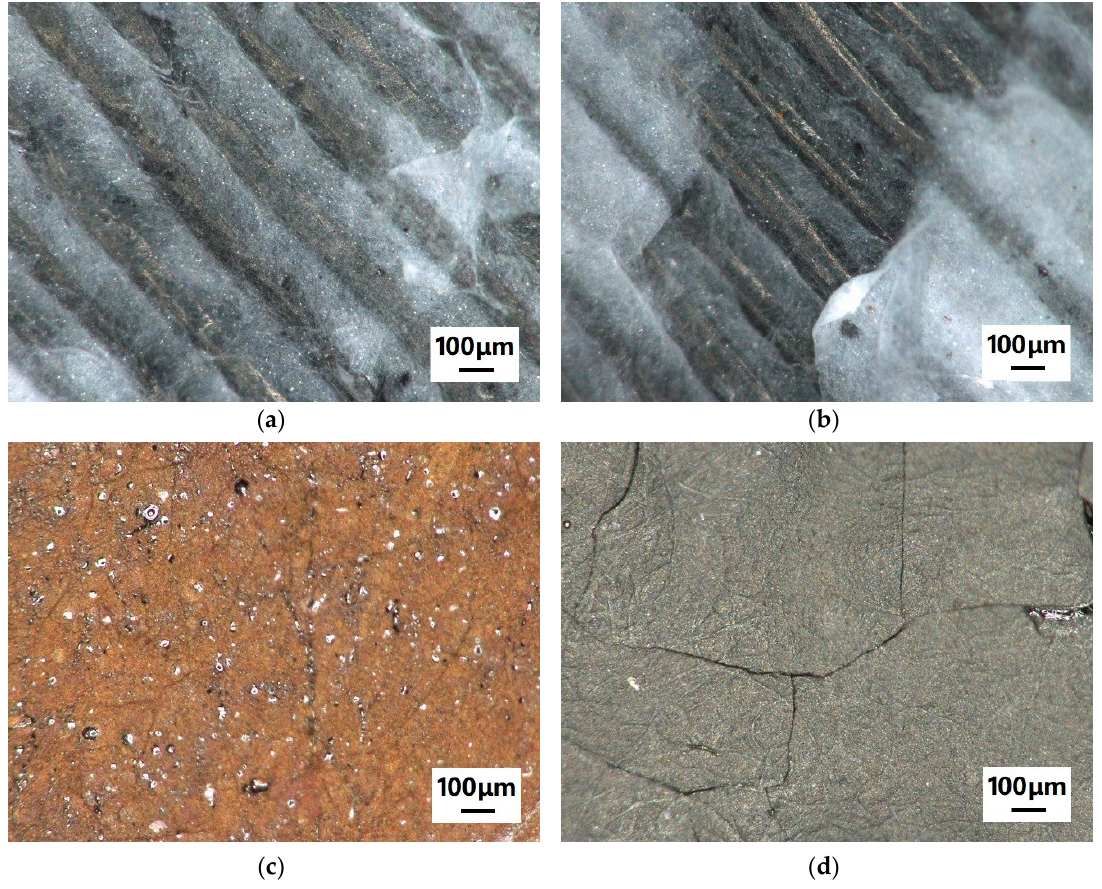
Figure 5. Optical microscopic images of PAN nanofiber mats after 3D printing and being peeled off the printed polymer: ( a ) PAN on aluminum (electrospun with 80 kV)—average situation; ( b ) PAN on aluminum (electrospun with 80 kV)—thinnest nanofiber “coating” found on all samples; ( c ) stabilized PAN (electrospun with 80 kV); and ( d ) carbonized PAN (electrospun with 50 kV).